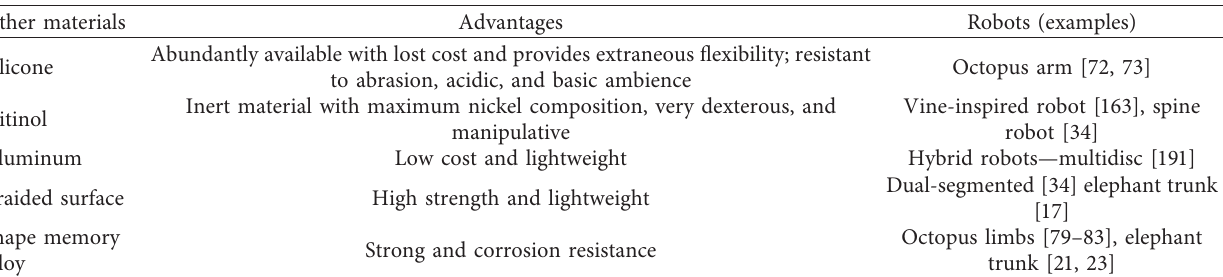
Table 5: Other material applications—continuum robot